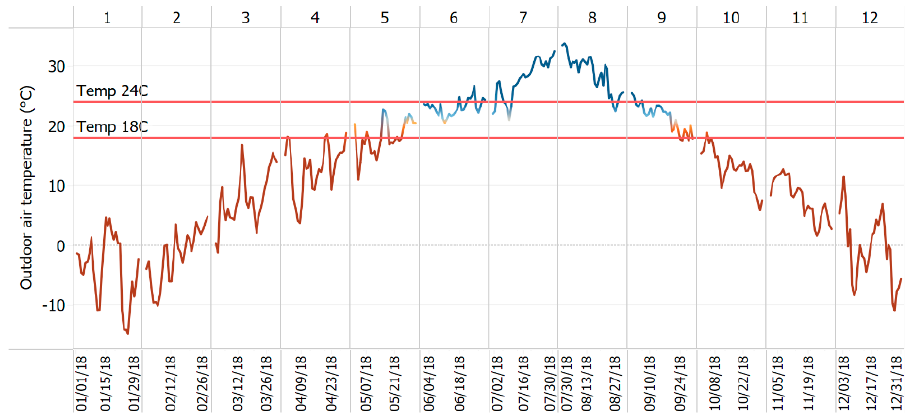
Figure 6. Daily mean outdoor air temperatures in 2018 in Seoul, South Korea. Source: KMA Weather Data Service [40].